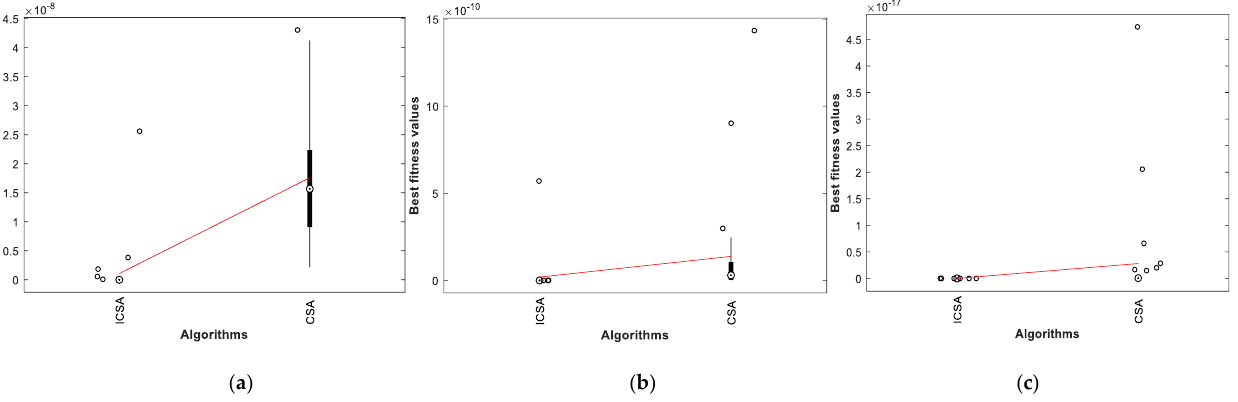
Figure 29. Boxplot of CSA and ICSA for various test cases : ( a ) Boxplot for F10; ( b ) Boxplot for F11; ( c ) Boxplot for F12.